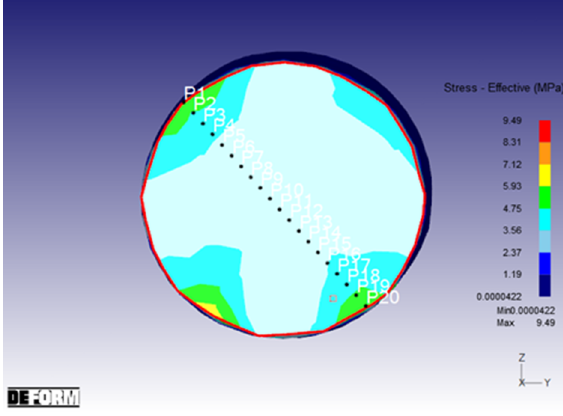
Figure 5. Point tracking along the cross section of the rod.